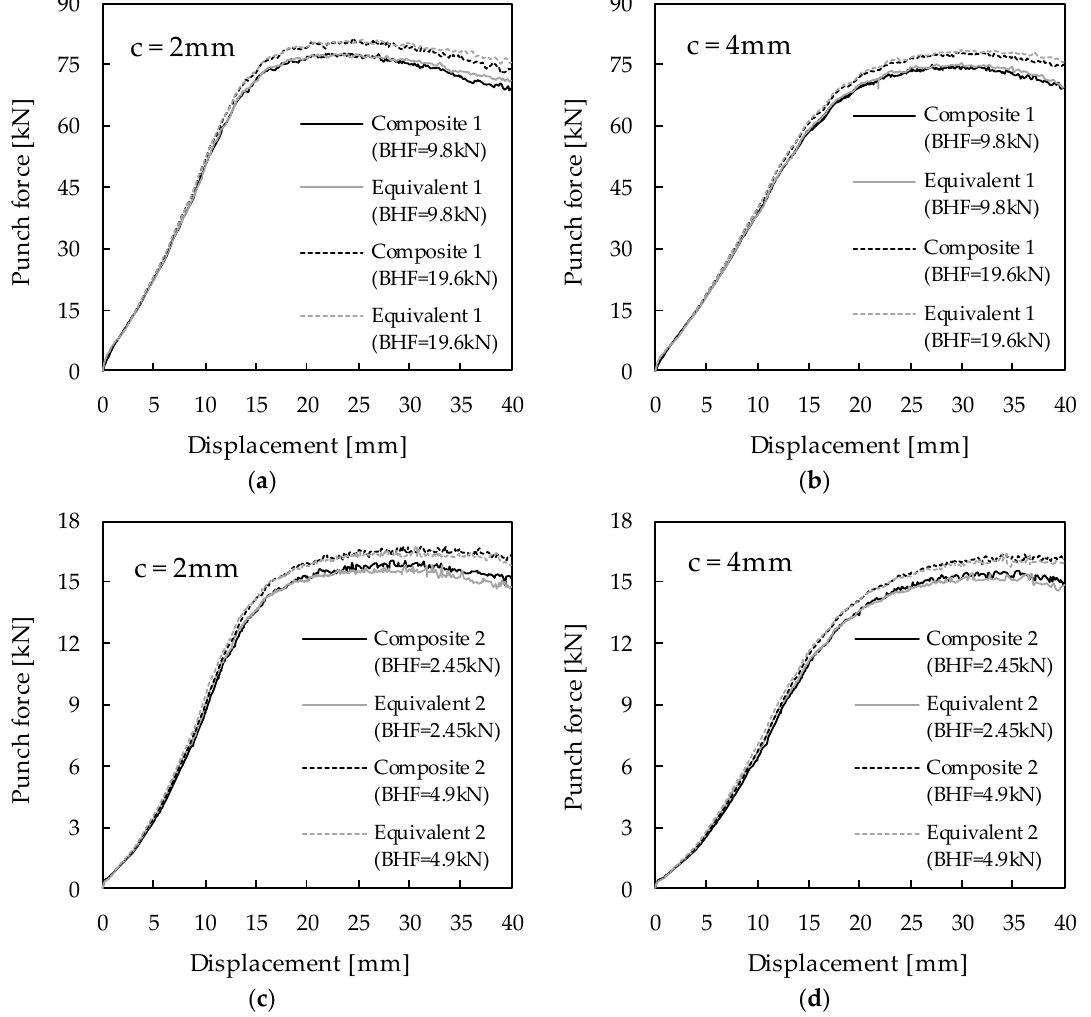
Figure 13. Force vs. displacement of the punch during the square cup forming process, for two values of clearance, c: ( a ) and ( b ) Composite 1 and equivalent material 1, for c = 2 mm and 4 mm, respectively; ( c ) and ( d ) Composite 2 and equivalent material 2, for c = 4 mm, respectively.